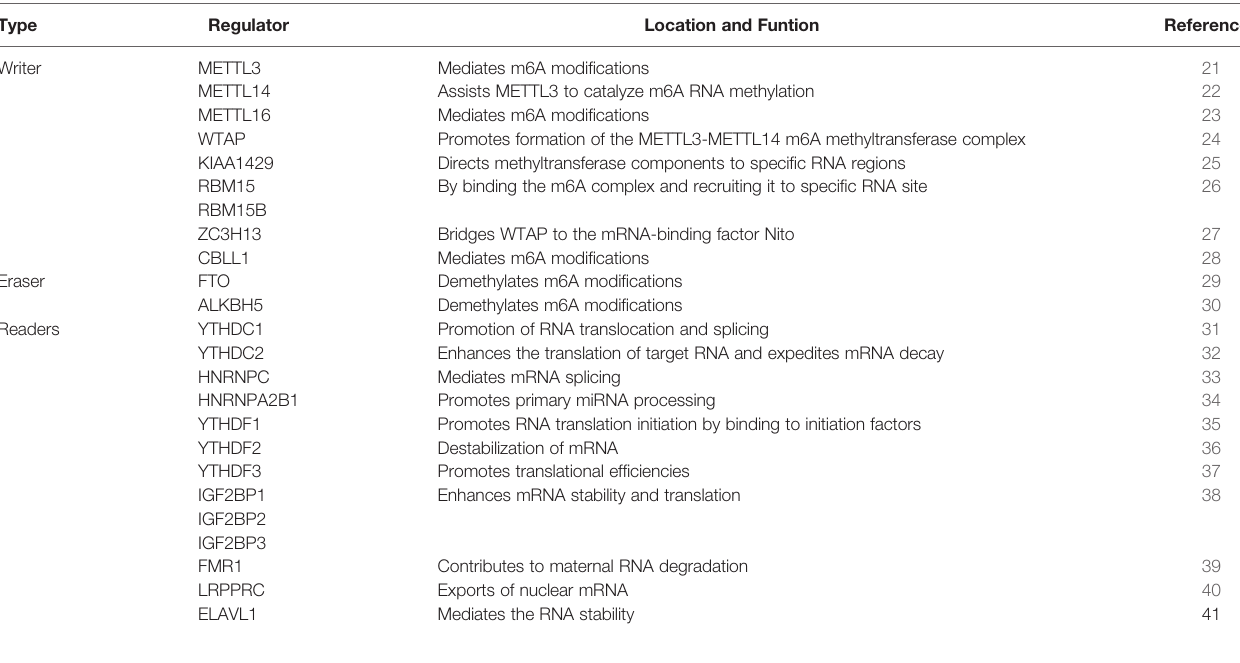
TABLE 1 | 24 m6A regulators and their functional roles in RNA